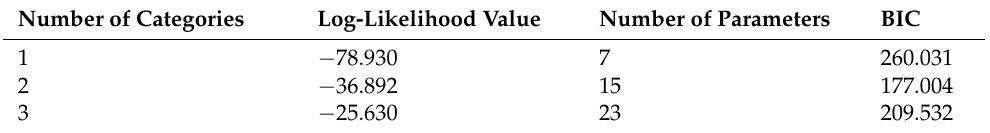
Table 2. The results of determining the potential categories to which the production methods belong. Number of